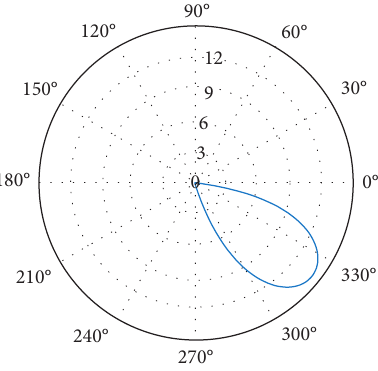
Figure 12: Radiation diagram for the BTS directing maximum power by method PSO (14.00dBi) to the test remote device ( − 42 ° ≡ 318 ° ). View in the plane azimuthal ( x − y